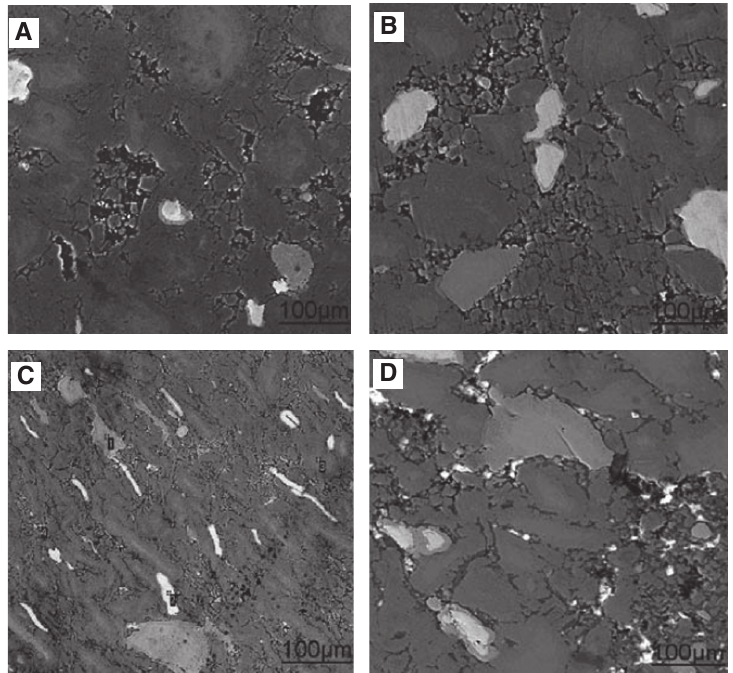
addition amounts: (A) 5%, (B) 10%, (C) 15%, and (D) 20%. 2